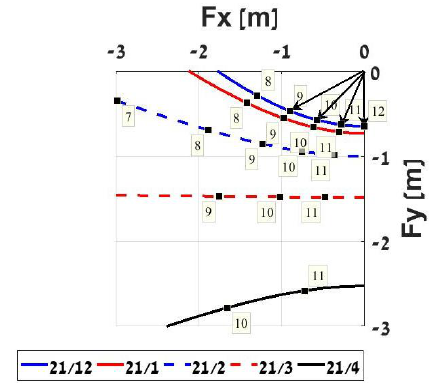
Figure 3. Shadow trajectory by horizontal pole on a wall, December to April on 21st day.